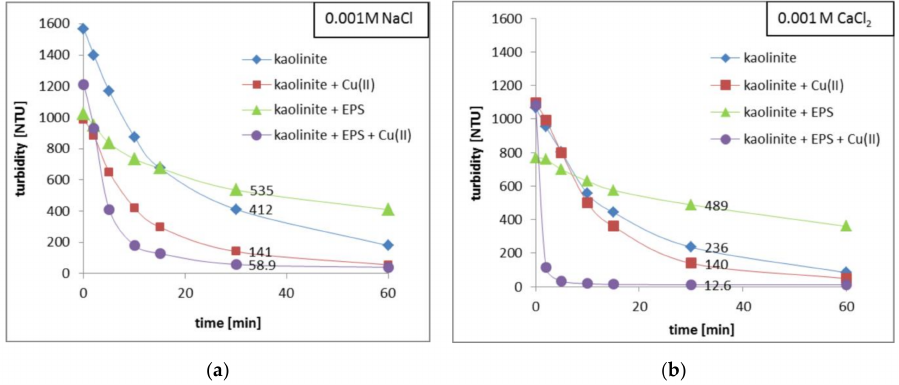
Figure 7. Turbidity changes in kaolinite suspension without and with Cu(II) ions and/or EPS